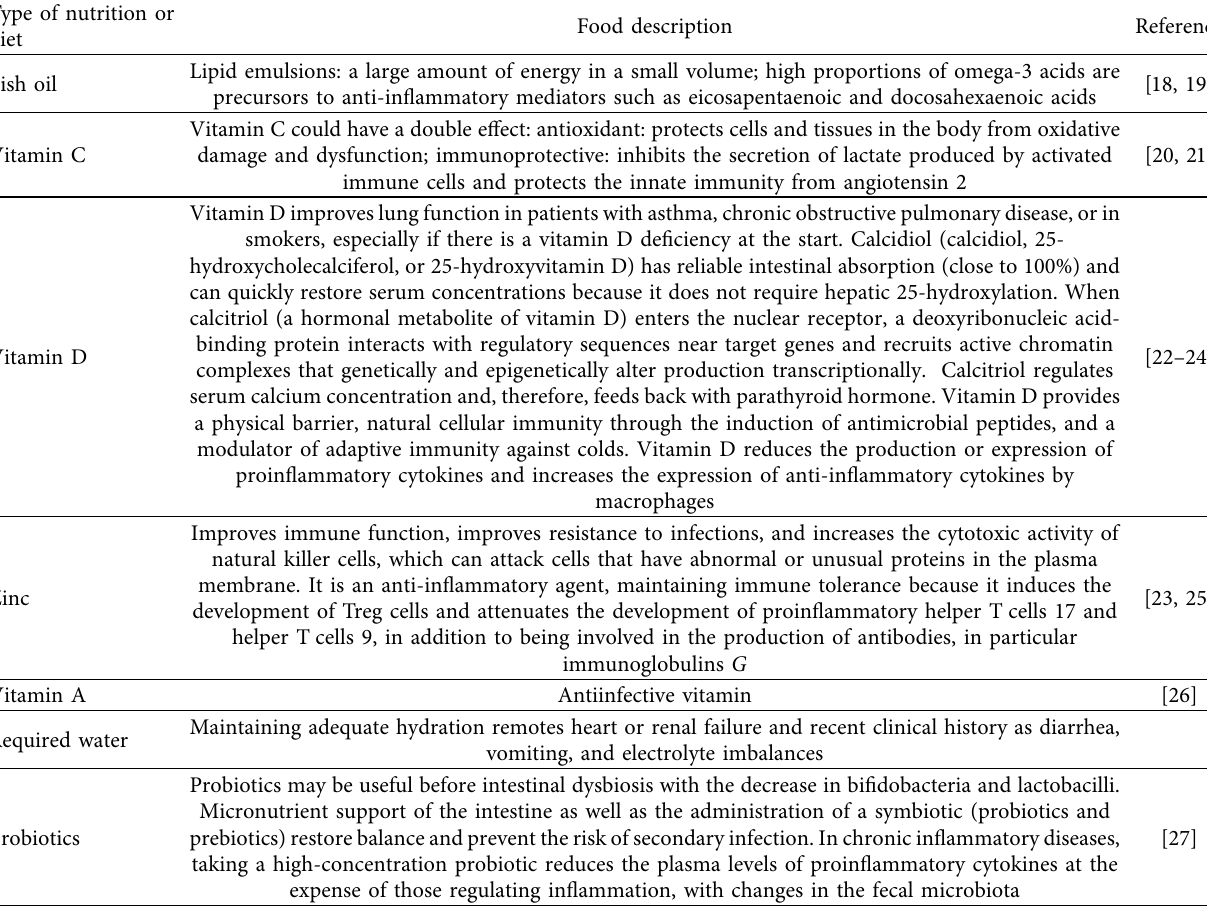
Table 1: Nutritional support for COVID-19